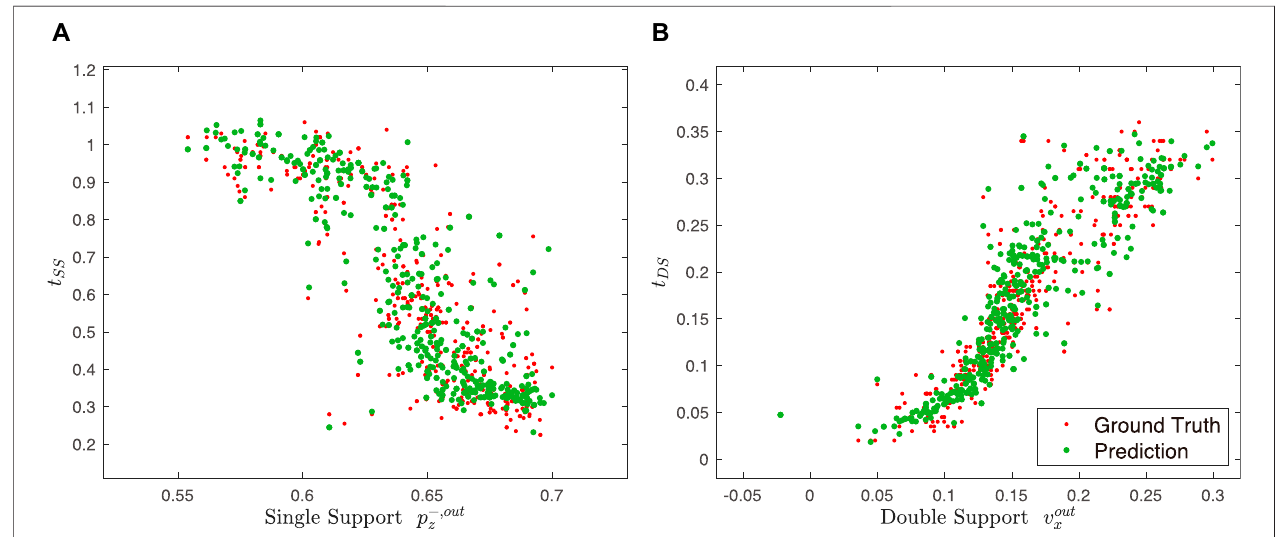
FIGURE7| Examplesoftheresultsofthetraining. (A) showsthetrainedrelationshipbetweenthelengthofthephasetime, t SS ,andthe x -coordinateofthefrontfoot at the beginning of the phase, p − , out z , in the case of a single support phase. (B) shows between the phase time, t DS , and the velocity of CoM in Z -direction when it leaves the phase, v out x , in the case of a double support phase.